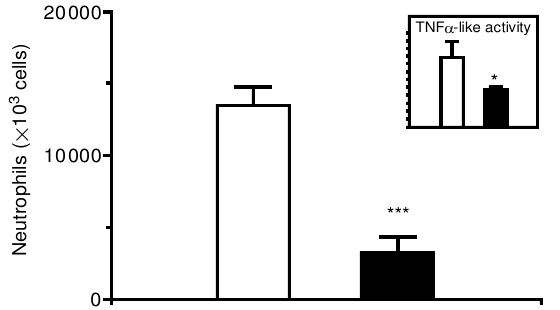
FIG. 6. Effects of cycloheximide (CHX) (1 mg / kg, i.p. 2 h before LPS) with the restoration of LPS-induced neutrophil recruitment and of following replenishment with alveolar macrophages in rat air pouches. Animals were treated with CHX or its vehicle, i.p. for 2 h before bronchoalveolar lavage. Replenishment was performed with 10 4 macro- phages (1 ml) for 0.5 h, then LPS or PBS stimulation were tested (200 ng, 2 h, 1 ml). Results are expressed as mean SEM of total number of cells for n = 6 experiments for the recruitment and of the TNF a -like activity (inset) recovered in the air pouch washing supernatants for n = 6 under the same conditions. Comparison was performed for CHX ( j ) vs. its vehicle ( h ) ( P , 0.01, P , 0.001).